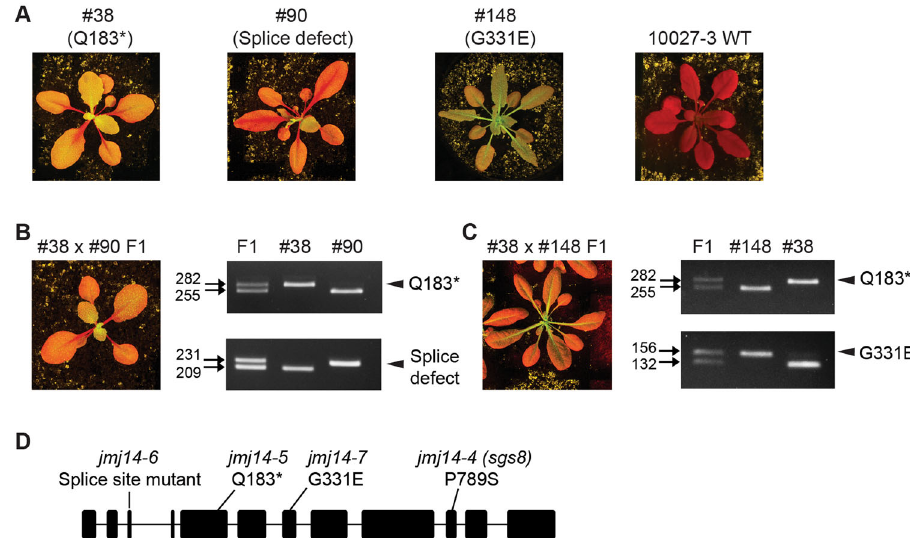
Fig. 1 Three new alleles of jmj14 show defects in systemic PTGS of GFP . A Rosette GFP phenotypes of EMS#38 (Q183*; jmj14-5 ), EMS#90 (splicing defect; jmj14-6 ) and EMS#148 (G331E; jmj14-7 ). Transgenic line 10027-3 wild type (WT), the parent used in the genetic screen to identify jmj14-5 , jmj14-6 and jmj14-7 , shows systemic PTGS of GFP . B , C EMS#90 (splice site mutant) and EMS#148 (G331E), respectively, were not complemented by EMS#38 (Q183*) as F1 plants from these crosses showed defective systemic PTGS. JMJ14 PCR genotyping assays are shown in the right-hand side of panel B , C ; arrows indicate the size in bps of the larger jmj14 mutant allele and smaller WT allele for each PCR test and arrowheads indicate the diagnostic mutant jmj14 allele compared to respective WT allele. The results for one F1 plant from each cross are shown in the Figure, however, we con fi rmed the phenotype and genotype of at least four F1 plants from each cross. D Location of the new jmj14 mutations and the previously reported jmj14 allele, jmj14-4 (P789S) 26 in the JMJ14 locus (AT4G20400). Exon and intron sequences are indicated by thick and narrow lines, respectively. Rosette images are of plants grown in soil under long-days for 4 weeks after planting. Uncropped and unprocessed scans of images of Fig. 1A – C are provided as a Source Data fi